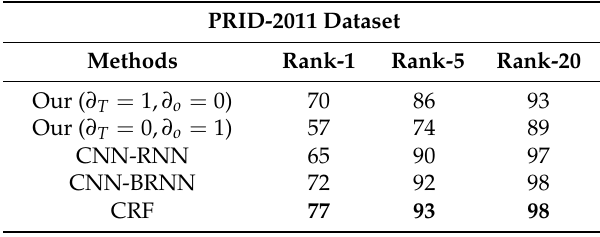
Table 9. Verification experiment results for the independent effectiveness of each stream feature substructure on the PRID-2011 dataset in terms of CMC